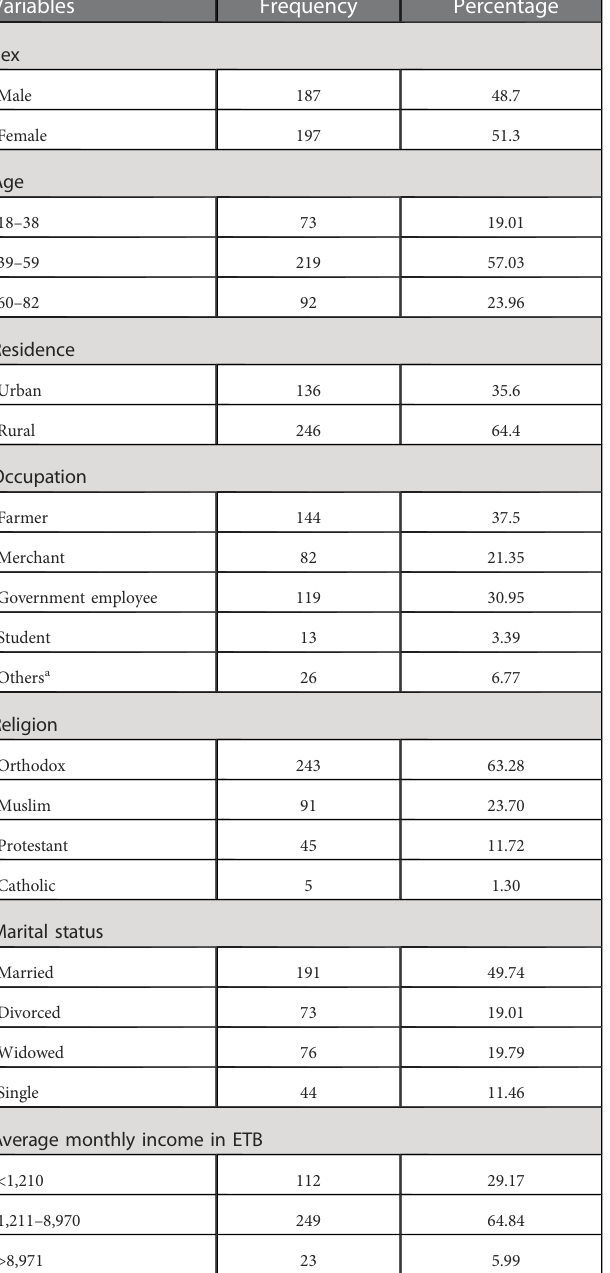
TABLE 2 Clinical and behavioral characteristics of adult cancer patients evaluated at oncology unit in UoGCSH, Northwest Ethiopia, 2021 ( n =384).